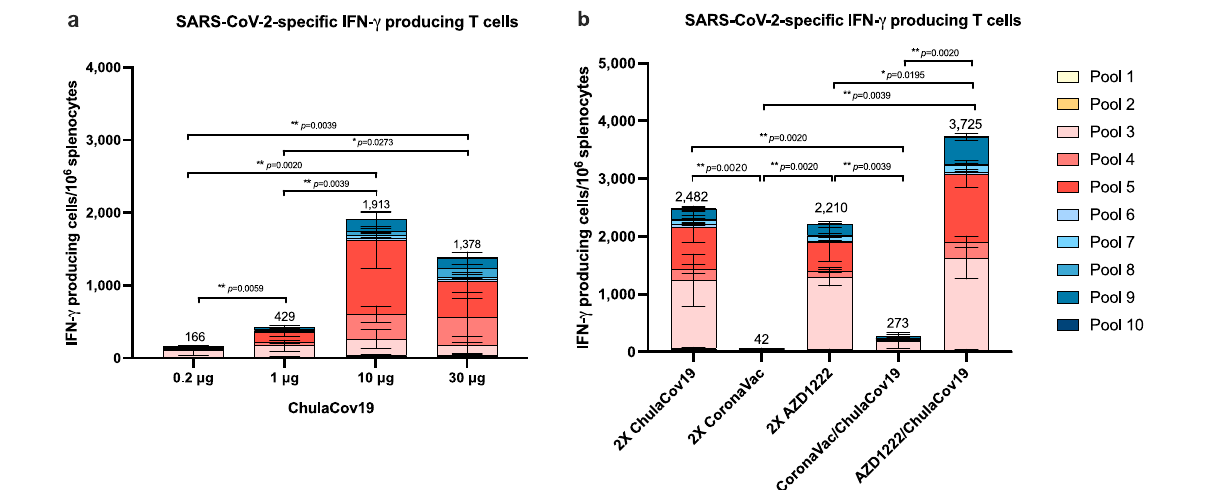
Fig. 5| InductionofS-speci fi cIFN- γ positiveT cellsinBALB/cmice.a micewere immunizedwith variousdoses of ChulaCov19 analyzed at2weeks afterthe second dose. b heterologous prime/boost study; mice were primed with CoronaVac or AZD1222 vaccine and boosted with ChulaCov19 (5 µ g). Homologouse prime/boost results of each vaccine were included. S-speci fi c IFN- γ positive T cells were deter- minedinduplicateassaysfrom5miceineachgroup.Barsrepresentthemean±SD